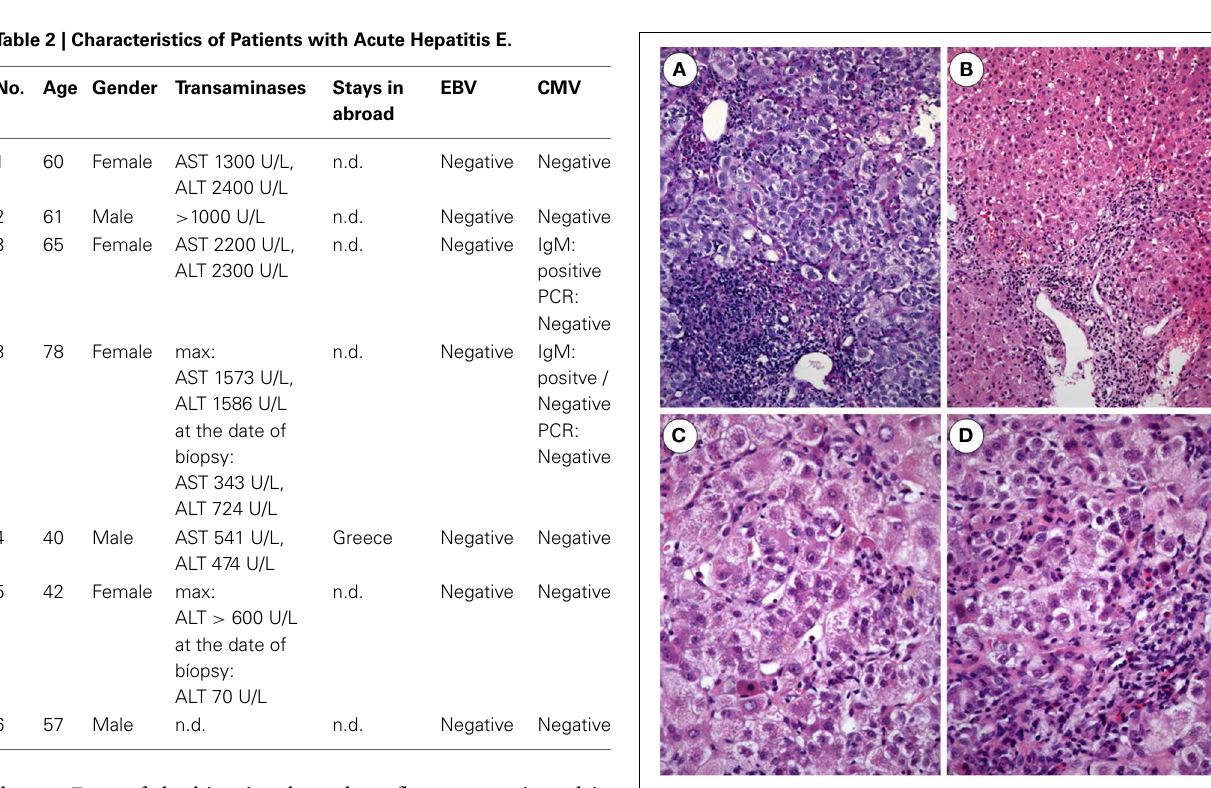
FIGURE 2 | Acute hepatitis E. (A) Expanded portal tract with dense inflammatory infiltrates mostly lymphocytes. Bile ducts display mild accompanying cholangitis (H and E × 100). (B) Acute hepatitis E with enlarged portal tract densely infiltrated by lymphocytes and some PMN leukocytes as well as some spotty necroses in the lobule (H and E × 80). (C) Acute hepatitis E with areas of spotty necrosis, aptotic bodies and infiltrates of lymphocytes, Kupffer cells and few polymorphnuclear leukocytes (H and E m × 240). (D) Biopsy from a patient with acute hepatitis E: the lobule shows foci of spotty necrosis, ballooning of hepatocytes and infiltrates with lymphocytes and